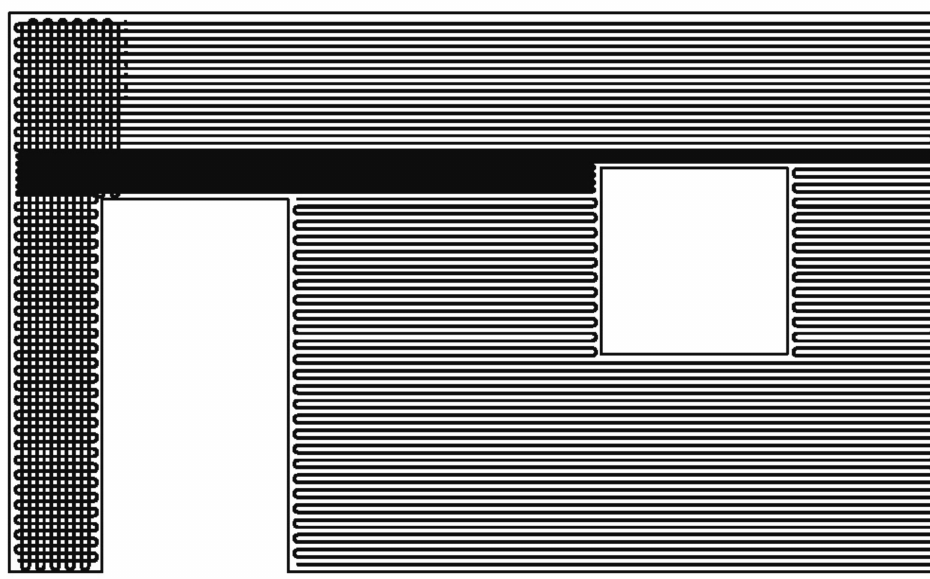
Figure 11. Customized planar CF textile reinforcement for a door-window wall element.